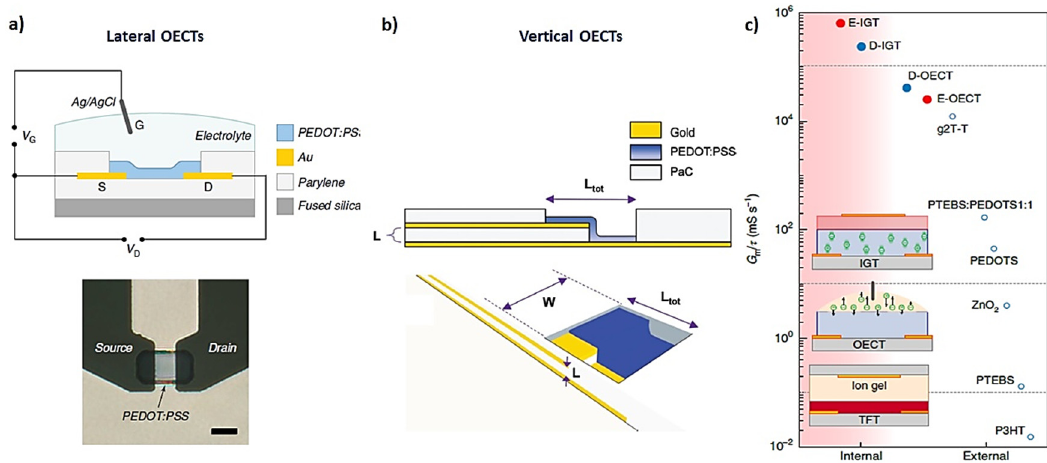
Figure 5. High-performance OECTs achieved by geometry design: ( a ) lateral OECT [10] (with permission from Springer Nature); ( b ) vertical geometry [14] (with permission from John Wiley and Sons, Inc.); ( c ) improvement of state-of-the art transistor performance by ion-gated electrochemical transistor (IGT) architecture (e-IGT and d-IGT; e = enhancement; d = depletion) [16,17] (with permission from Springer Nature).